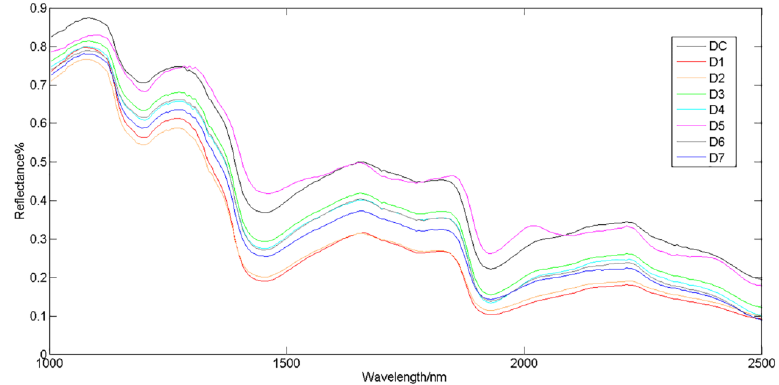
Figure 7. Average spectra of the germ region of all kernels under 8 different treatments.